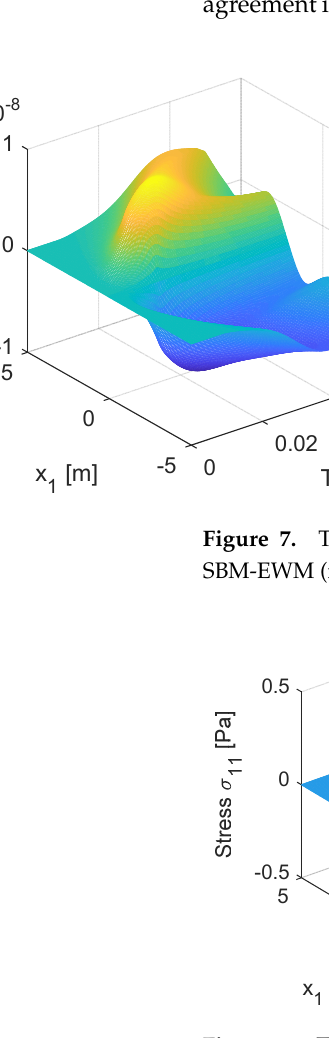
Figure 6. The sketch of the semi-infinite domain.